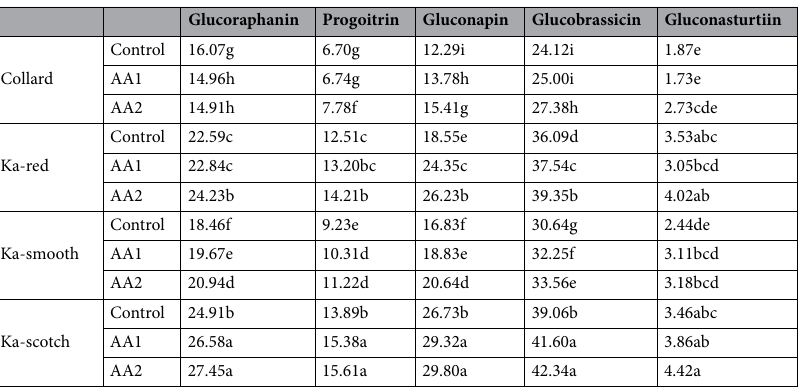
Table 5. Interaction effect of cabbage cultivar and AA application on glucosinolate content µM/g DW. Control control treatment, AA1 150 mg/L of amino acid, AA2 150 and 300 mg/L of amino acid. According to the least significant difference test, a column in each treatment and means followed by the same letter is not significantly different at P <